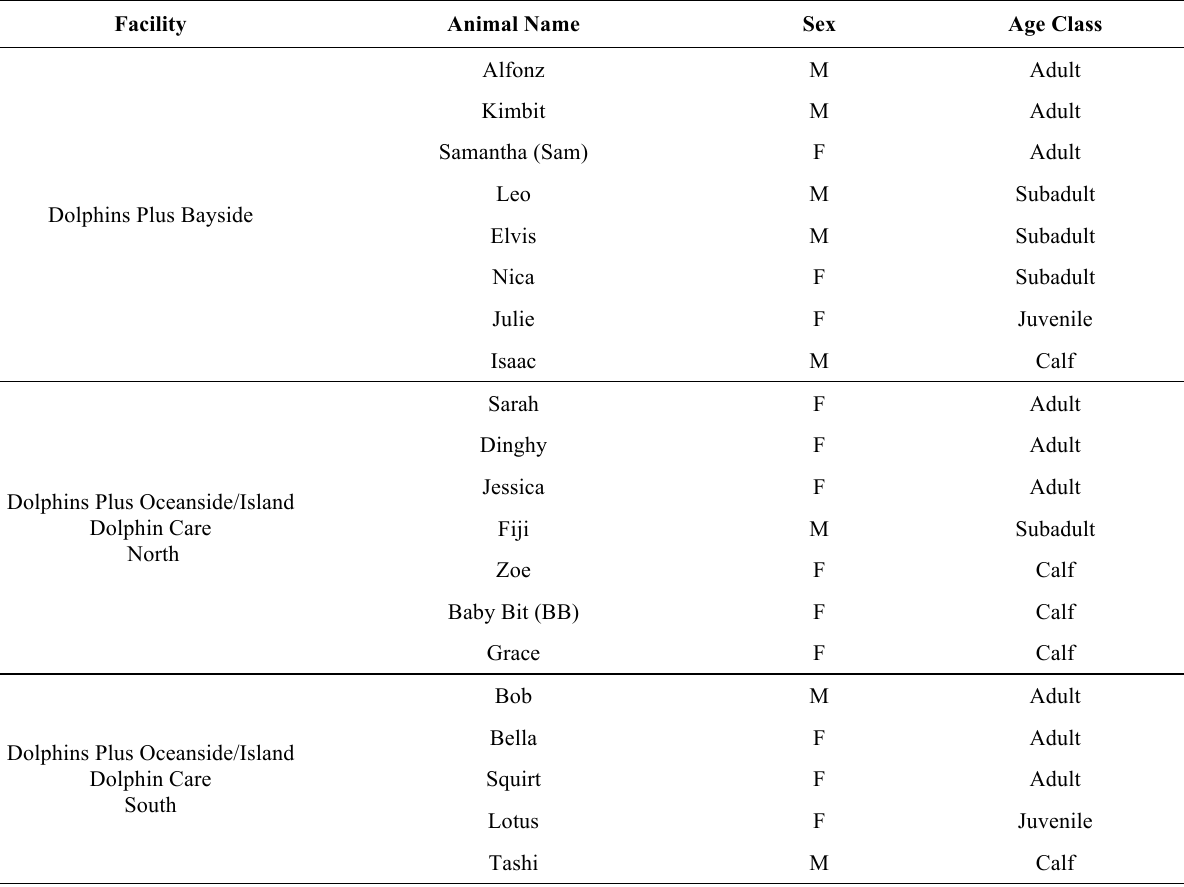
Dolphin Study Subjects: Location, Name, Sex, and Age Class